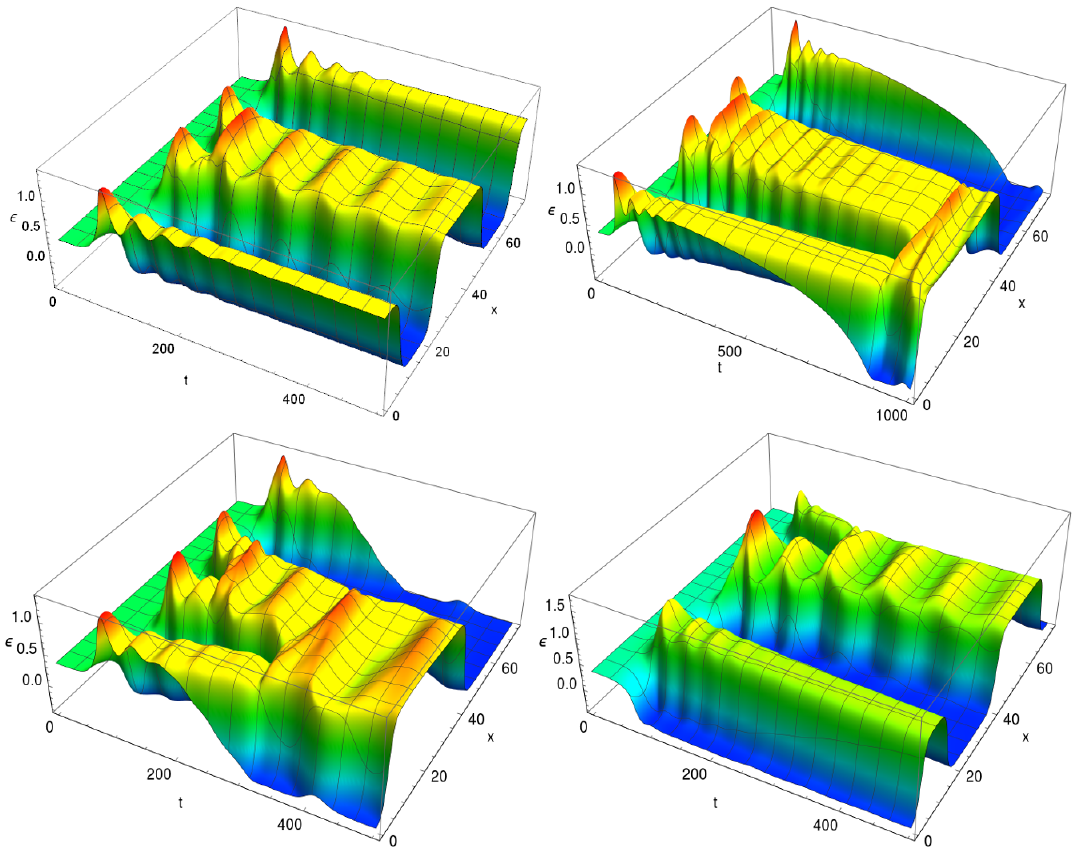
Figure 3 . Time dependence of energy density for initial perturbations with varying degree of asymmetry. Top row: (cid:11) = 0 : 5 (left) and (cid:11) = 0 : 25 (right), bottom row: (cid:11) = 0 : 1 (left) and (cid:11) = (cid:0) 1 : 0